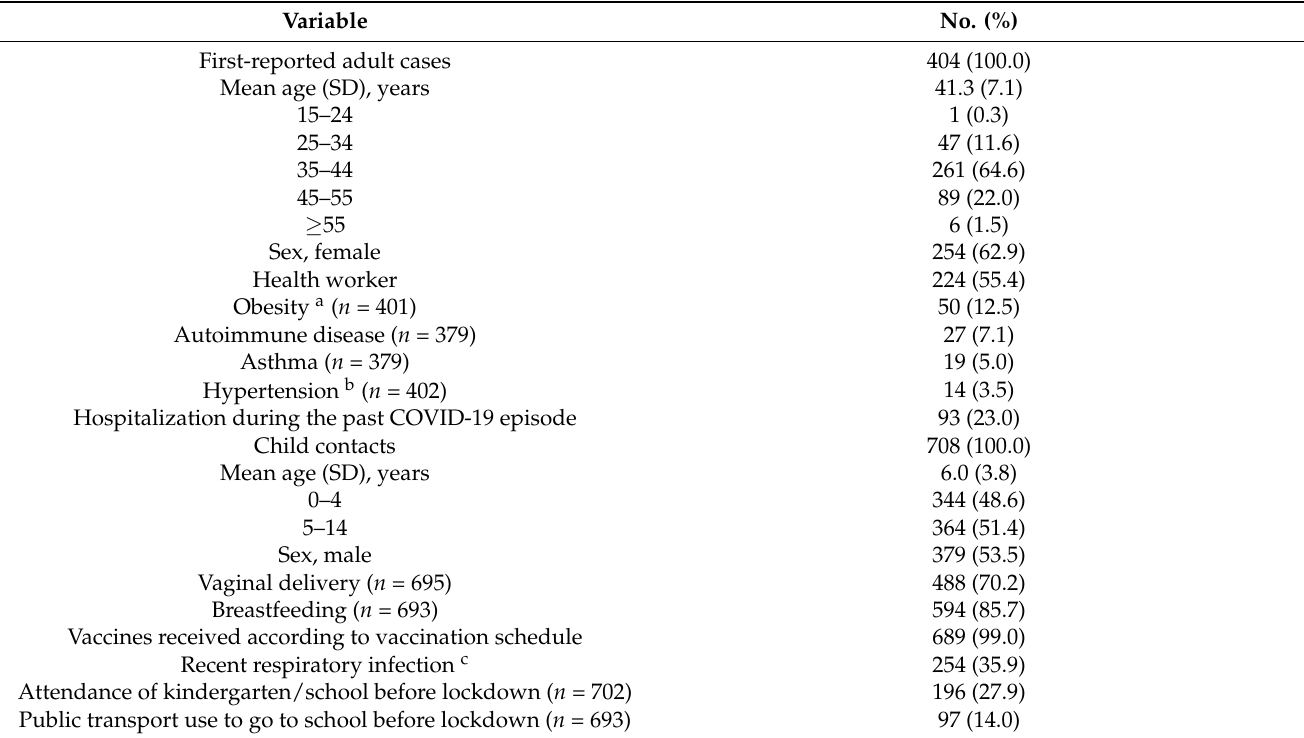
Table 1. Epidemiological and clinical characteristics of